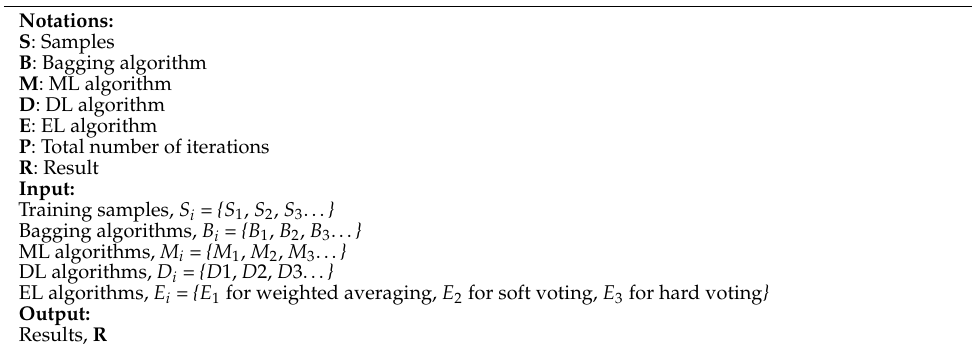
Figure 5. The workflow of FRIEND. Algorithm 2: Pseudocode of EDL algorithm employed in